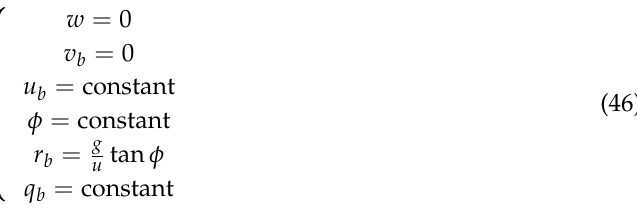
M horizontal fin Figure 14. Simulation results in coordinated turn under Configuration WDH. ( a ) Compound inputs; ( b ) Helicopter inputs; ( c ) Velocities; ( d ) Angular velocities; ( e ) Euler angles; ( f ) Distances; ( g ) Lateral moments; ( h ) Pitch moments. The simulation in coordinated turn proves the feasibility of the elevator component and the differential maneuver of the aileron-wing. The simulation confirms the effectiveness of SCH nonlinear model in a wider route setting. 6. Conclusions This article offers a detailed analysis of the nonlinear mathematical model of an innovative small-scale compound helicopter. Three compound configurations were studied. An 11-state nonlinear simulation model was established, considering a free-rotate wing, ducted fan model, horizontal stabilizer model and so forth. Apart from the linear coupled roll pitch dynamics and the linear yaw dynamics, 10 main parameters in the nonlinear model were modified with the help of